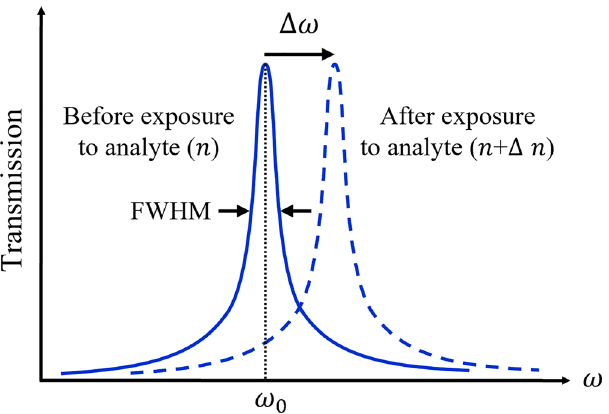
Figure 1. The sensing performance of an optical RI